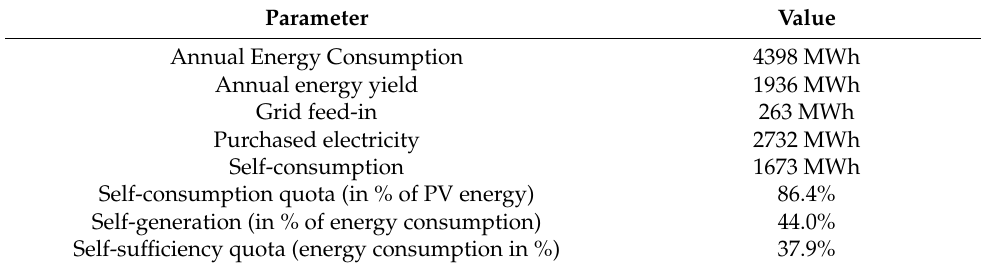
Table 5. Distribution of PV energy and consumption (scenario with energy storage) .